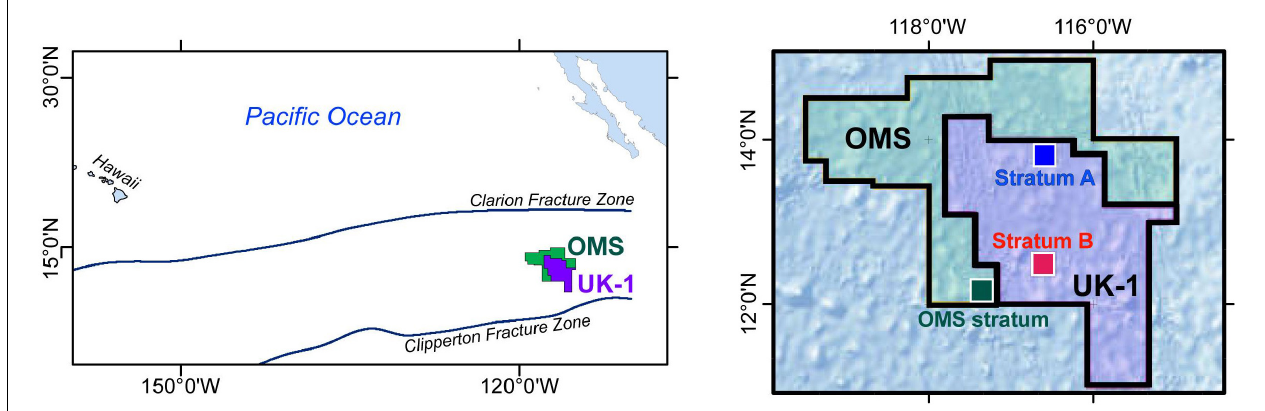
FIGURE 1 | (Left) Location of the Ocean Mineral Singapore (OMS) and UK-1 exploration contract areas in the eastern Clarion-Clipperton Zone, equatorial Pacific. (Right) Location of UK-1 Strata A and B and the OMS stratum within the two contract